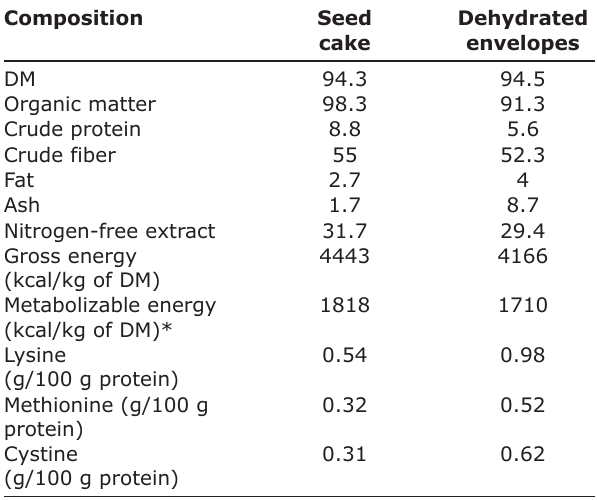
Table-1: Chemical composition of prickly pear processing by-products in % DM.